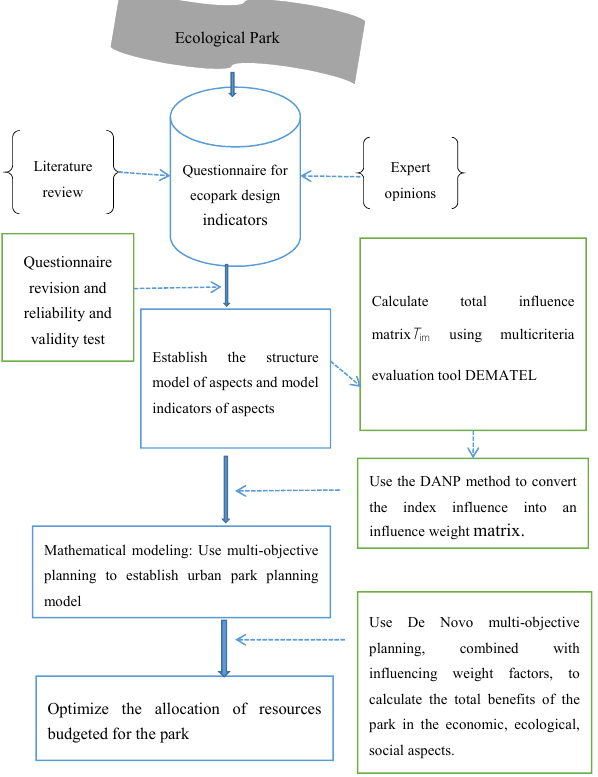
Figure 1. Research process.